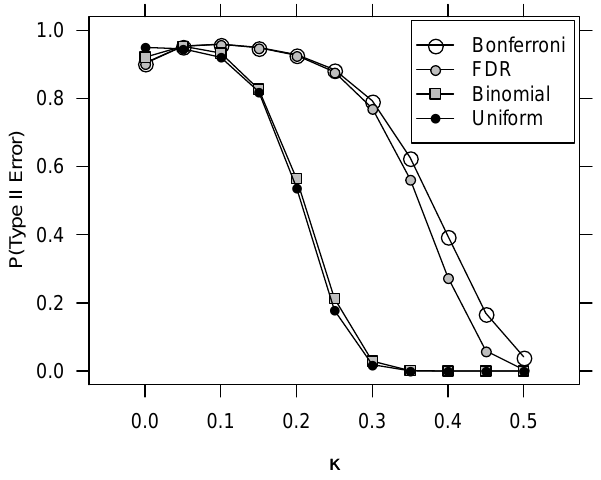
Fig. 5. Power of a type I left censored Gumbel PPCC hypothesis test combined with the four field significance level tests discussed in this paper against the reverse Weibull alternative. Power is a function of the reverse Weibull shape parameter κ > 0 . As κ increases, the distribution becomes less similar to the Gumbel distribution, so the differences are easier to